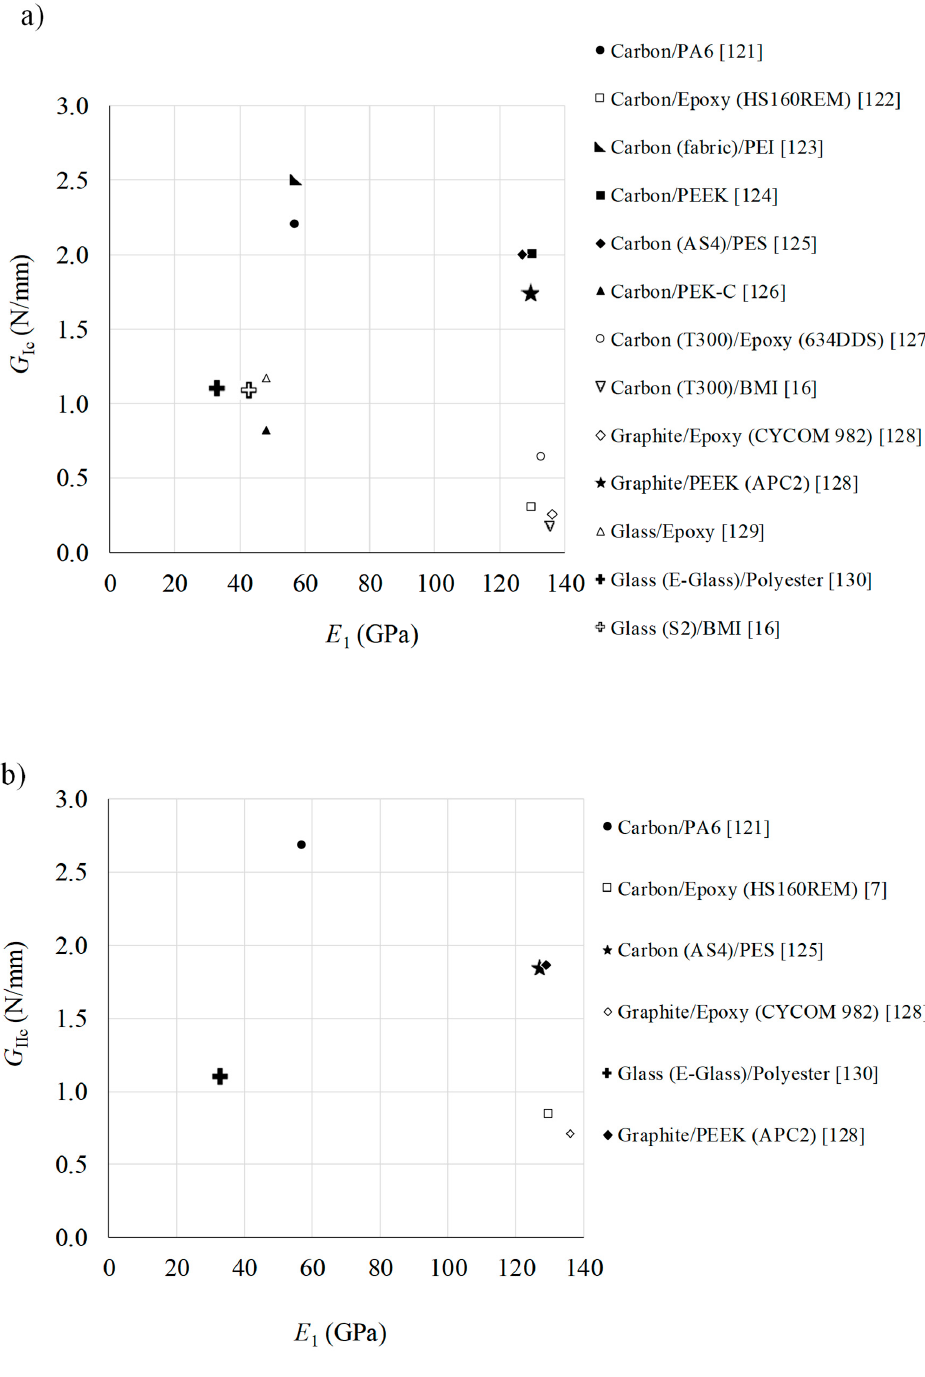
Figure 6. Comparison of critical energy release rates G Ic —( a ) and G IIc —( b ), and elastic modulus E 1 of unidirectional thermoset and thermoplastic based composites. Filled and hollow marks stands for thermoplastic and thermoset systems, respectively [7,16,121–130].